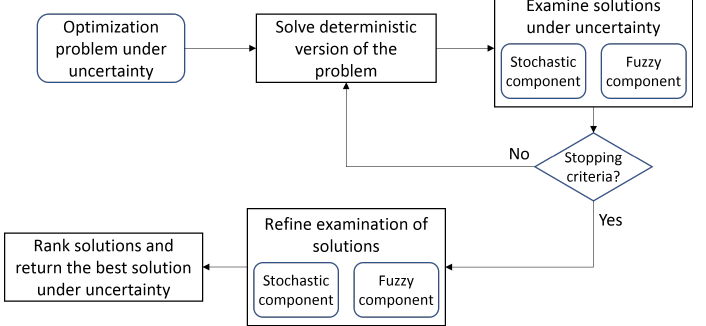
Figure 3. Schema of the fuzzy-simheuristic